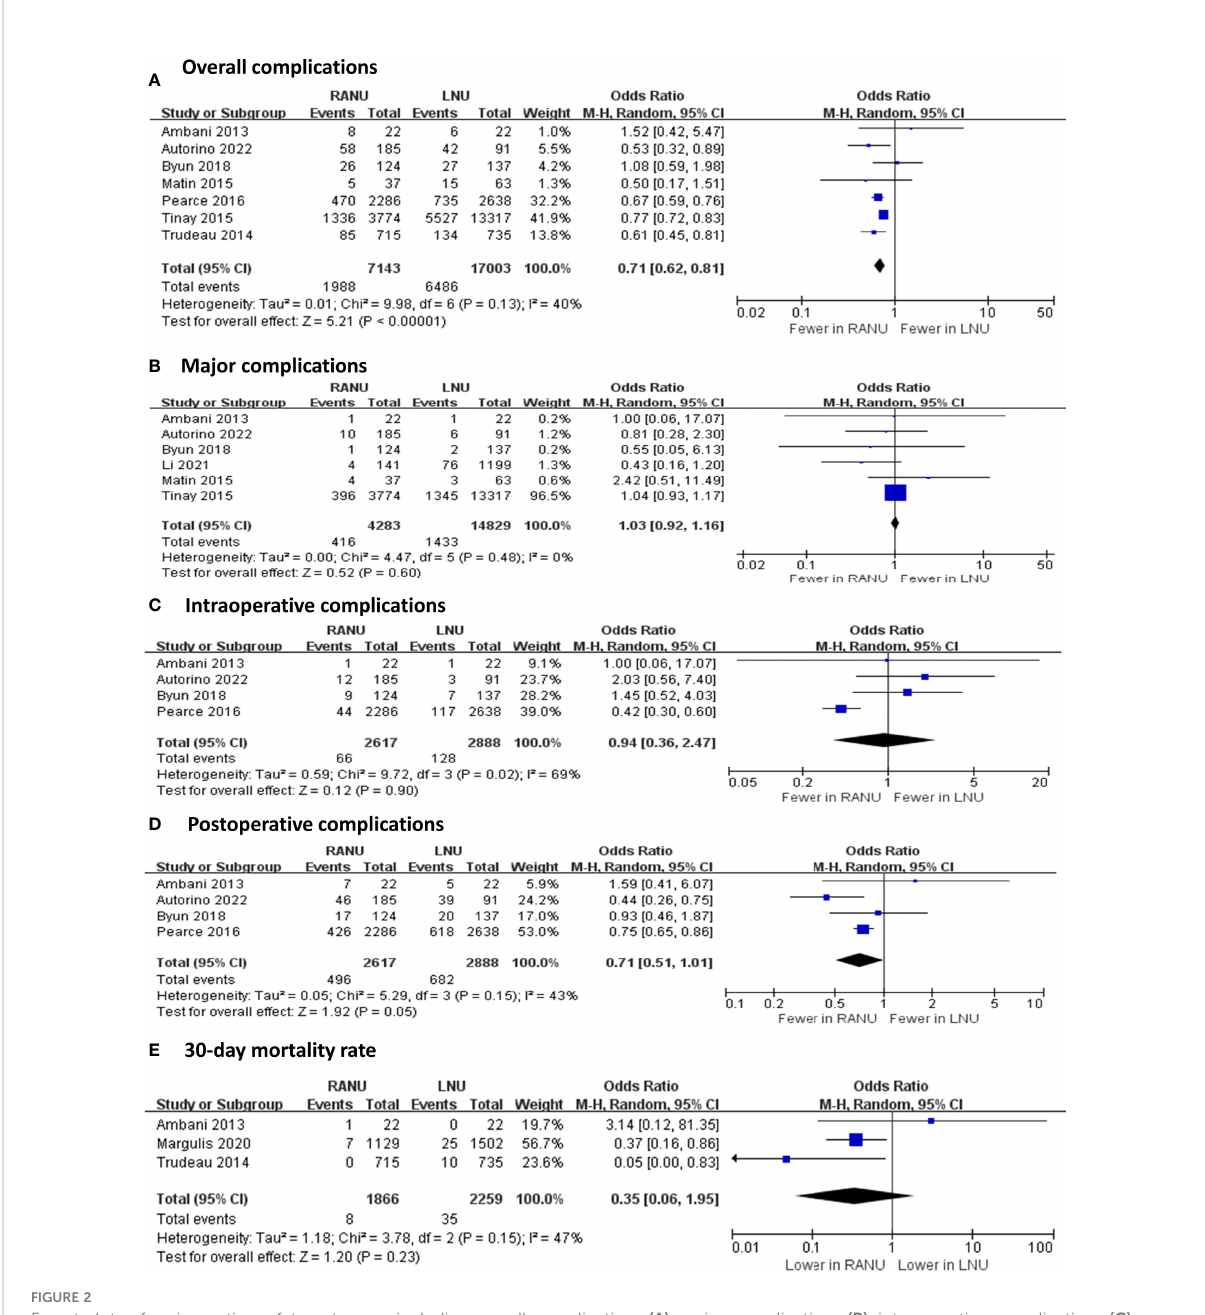
FIGURE 2 Forest plots of perioperative safety outcomes including overall complications (A) , major complications (B) , intraoperative complications (C) , postoperative complications (D) and 30-day mortality rate (E) for robotic-assisted nephroureterectomy (RANU) versus laparoscopic nephroureterectomy